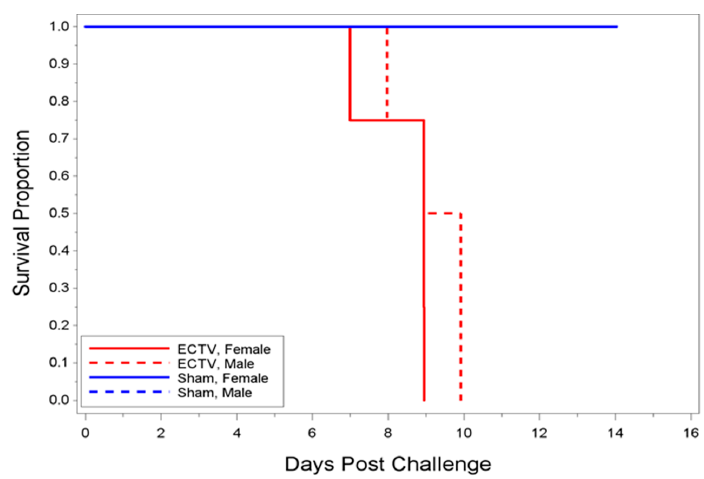
Figure 2. Kaplan–Meier Plot for ECTV ‐ Mos and sham animals. Two groups were assessed for data ( n = 8 per group). All animals infected with ECTV ‐ Mos succumbed to disease or were euthanized by 10 days PI. All mice inoculated with Dulbecco’s phosphate ‐ buffered saline (DPBS) survived until the end of study.